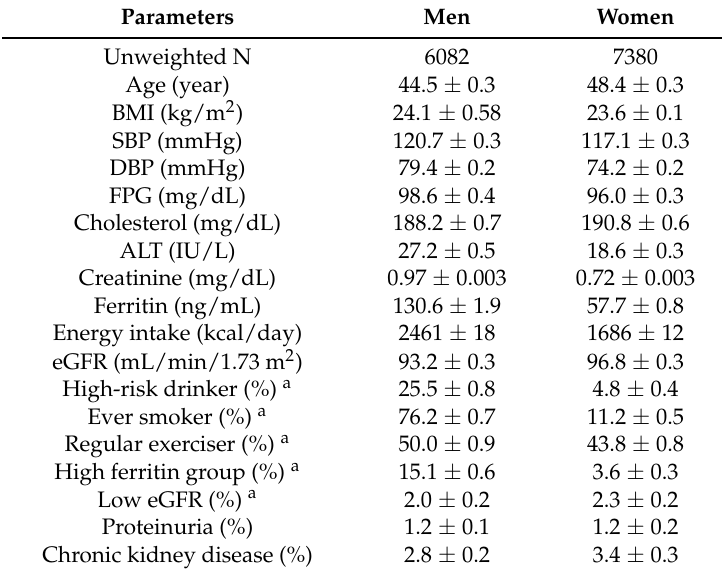
Table 1. Subject characteristics by